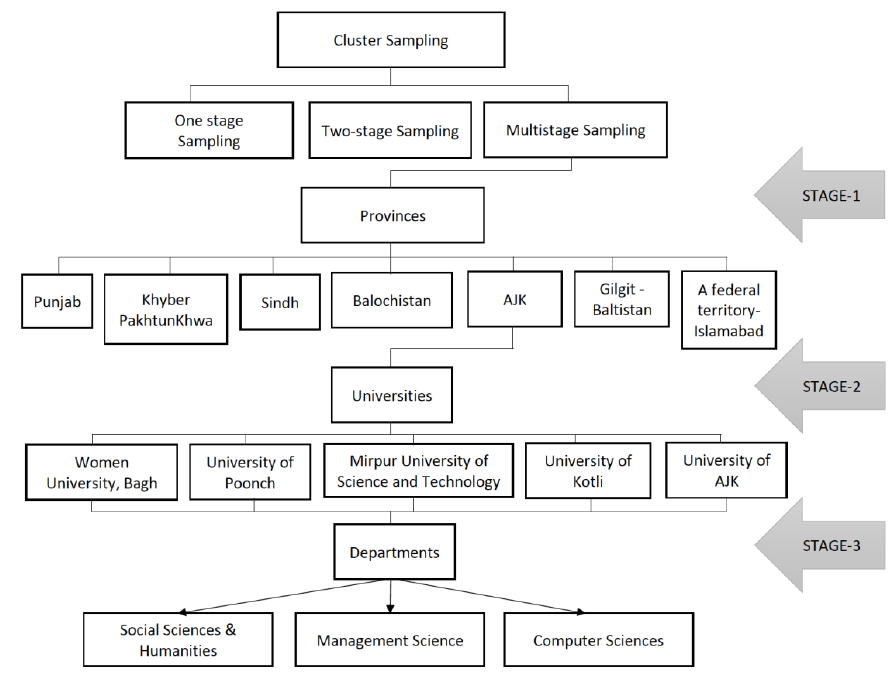
Figure 2. Sampling technique.